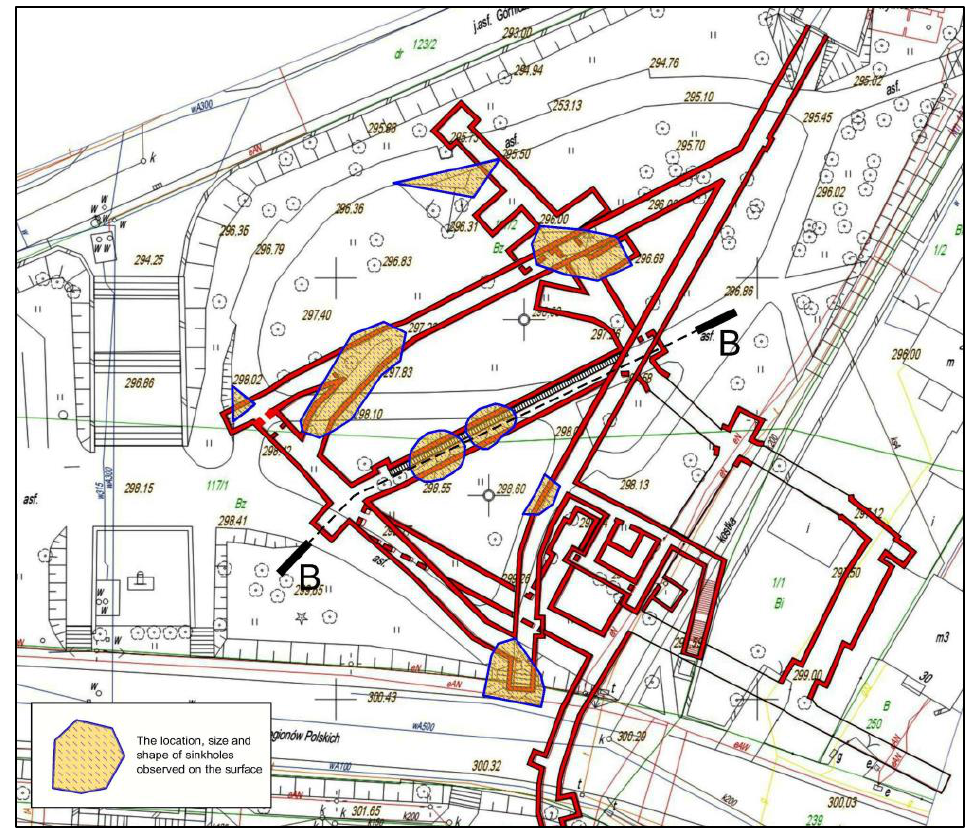
Figure 5. The location of cover-subsidence sinkholes confirmed during the revision in the year 2011 [16].